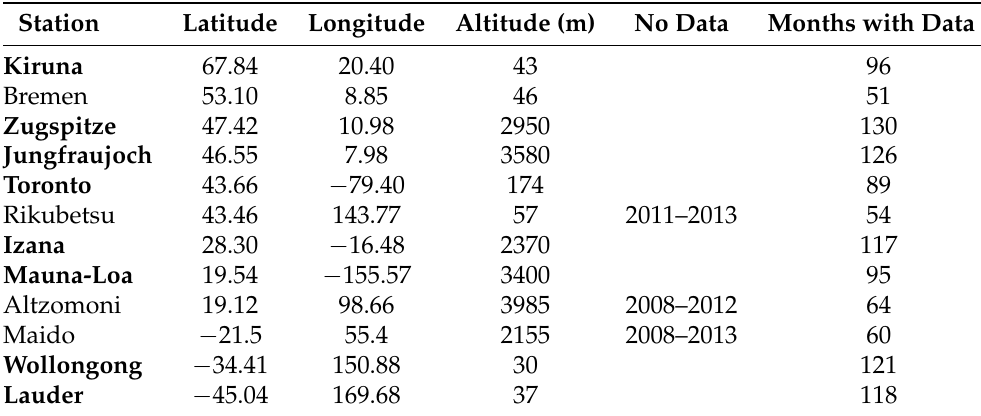
Table 1. List of NDACC stations with N 2 O measurements during the IASI period (2008–2018). Stations with names in bold face correspond to stations with continuous measurements during the 2008–2018